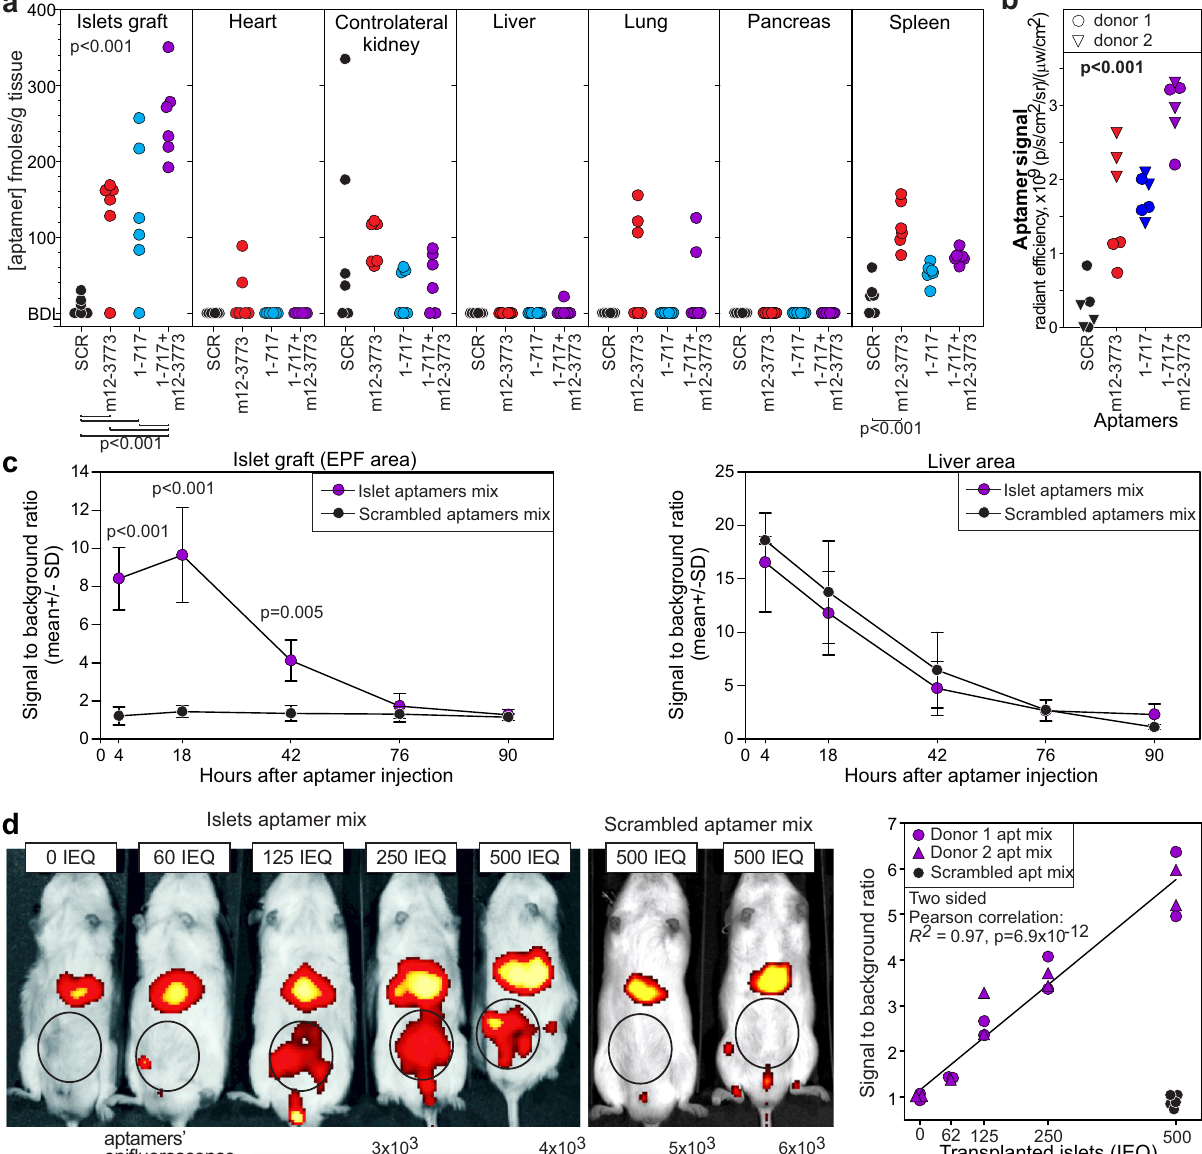
Fig. 5 Aptamer 1-717 and m12-3773 allow to measure human islet mass in vivo. a Aptamer 1-717 (12.5 pmoles/g), m12-3773 (12.5 pmoles/g), or an equimolar mixture of the two aptamers (6.25 pmoles/g each) were injected i.v. in NOG mice transplanted 21 days before with human islets (500 IEQ) under the kidney capsule. A mixture of scrambled aptamers was used as a negative control. After 24 h from aptamers injection, organs were collected, and aptamer concentration was determined by qRT-PCR. Two-tailed two-way ANOVA followed by Bonferroni multiple pairwise comparisons was performed. b Biotinylated aptamers 1-717, m12-3773, or an equimolar mixture of the two aptamers were complexed with AF750-streptavidin and injected i.v. in immunode fi cient NOG mice transplanted in the EFP with human islets (500 IEQ) 21 days before. IVIS was performed 4 h later. The signal from the graft site is reported. Two-tailed one-way ANOVA and posthoc multiple comparison p values are reported. c An equimolar mixture (12.5 pmoles/g) of aptamer 1-717 and aptamer m12-3773 complexed to AF750-streptavidin was injected i.v. in NOG mice transplanted 21 days earlier with human islets (500 IEQ) in the EFP IVIS was performed at the indicated timepoints. Data derived from n = 6 mice from two independent experiments. Two-sided, three-way ANOVA followed by Holm – Sidak multiple comparison analysis was performed. Multiple comparisons adjusted the p value of islet aptamer vs. scrambled are shown. d NOG mice were transplanted with different amounts of human islets in the EFP and injected i.v. 21 days later with AF750-streptavidin aptamer complexes. Signal in the graft site was measured by IVIS 4 h later. Data were derived from two independent experiments performed by two experimentalists. Pearson correlation is shown. Source data are provided as a Source Data fi